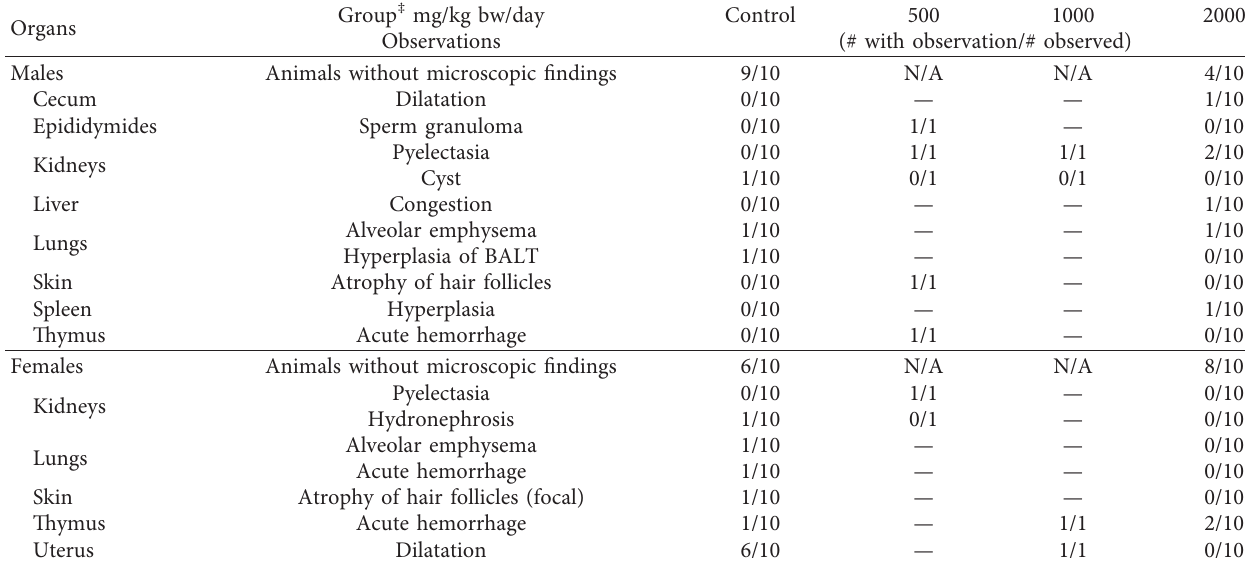
Table 12: Summary of histopathology, 90-day